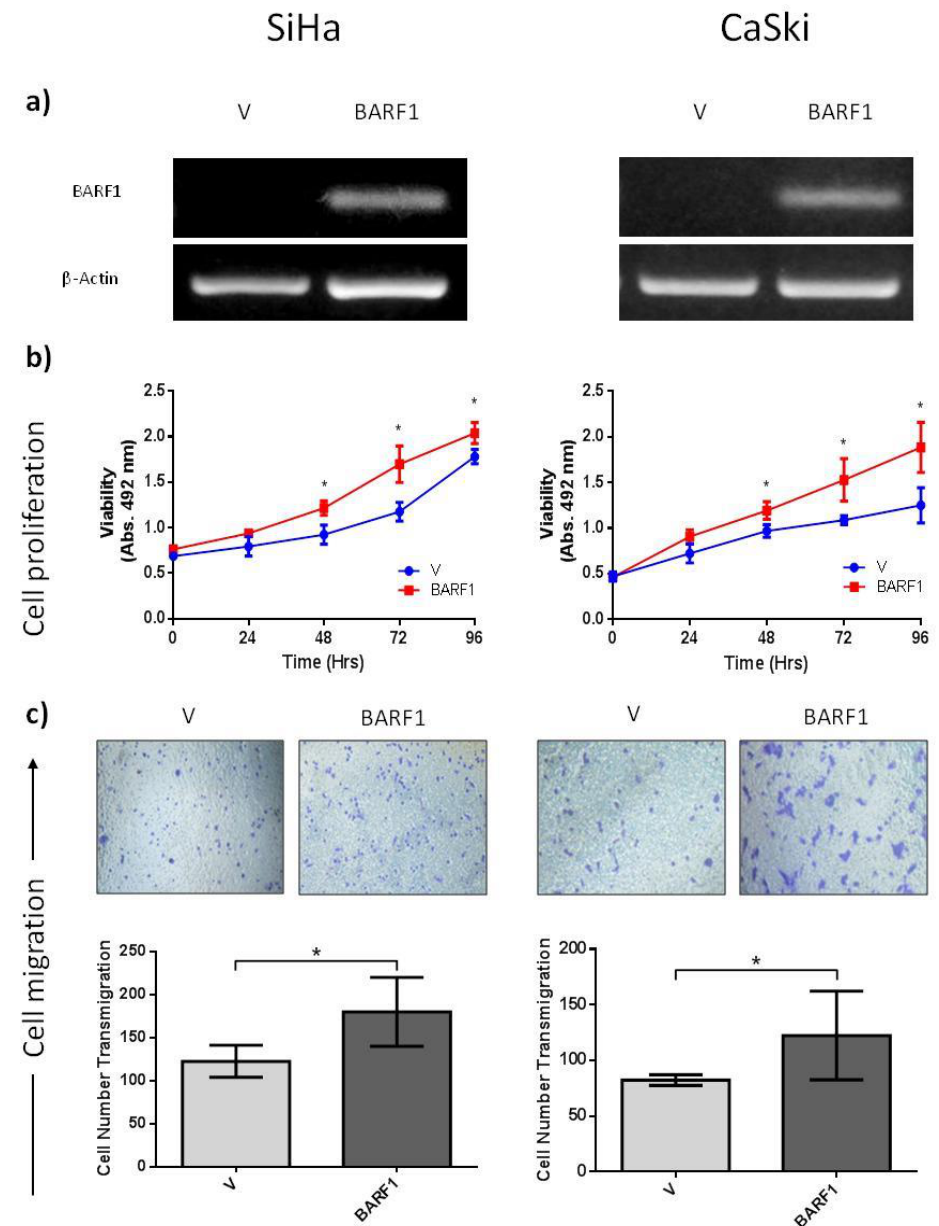
Figure 2. BARF1 increases cell proliferation and migration of HPV16-positive cervical cancer cells.